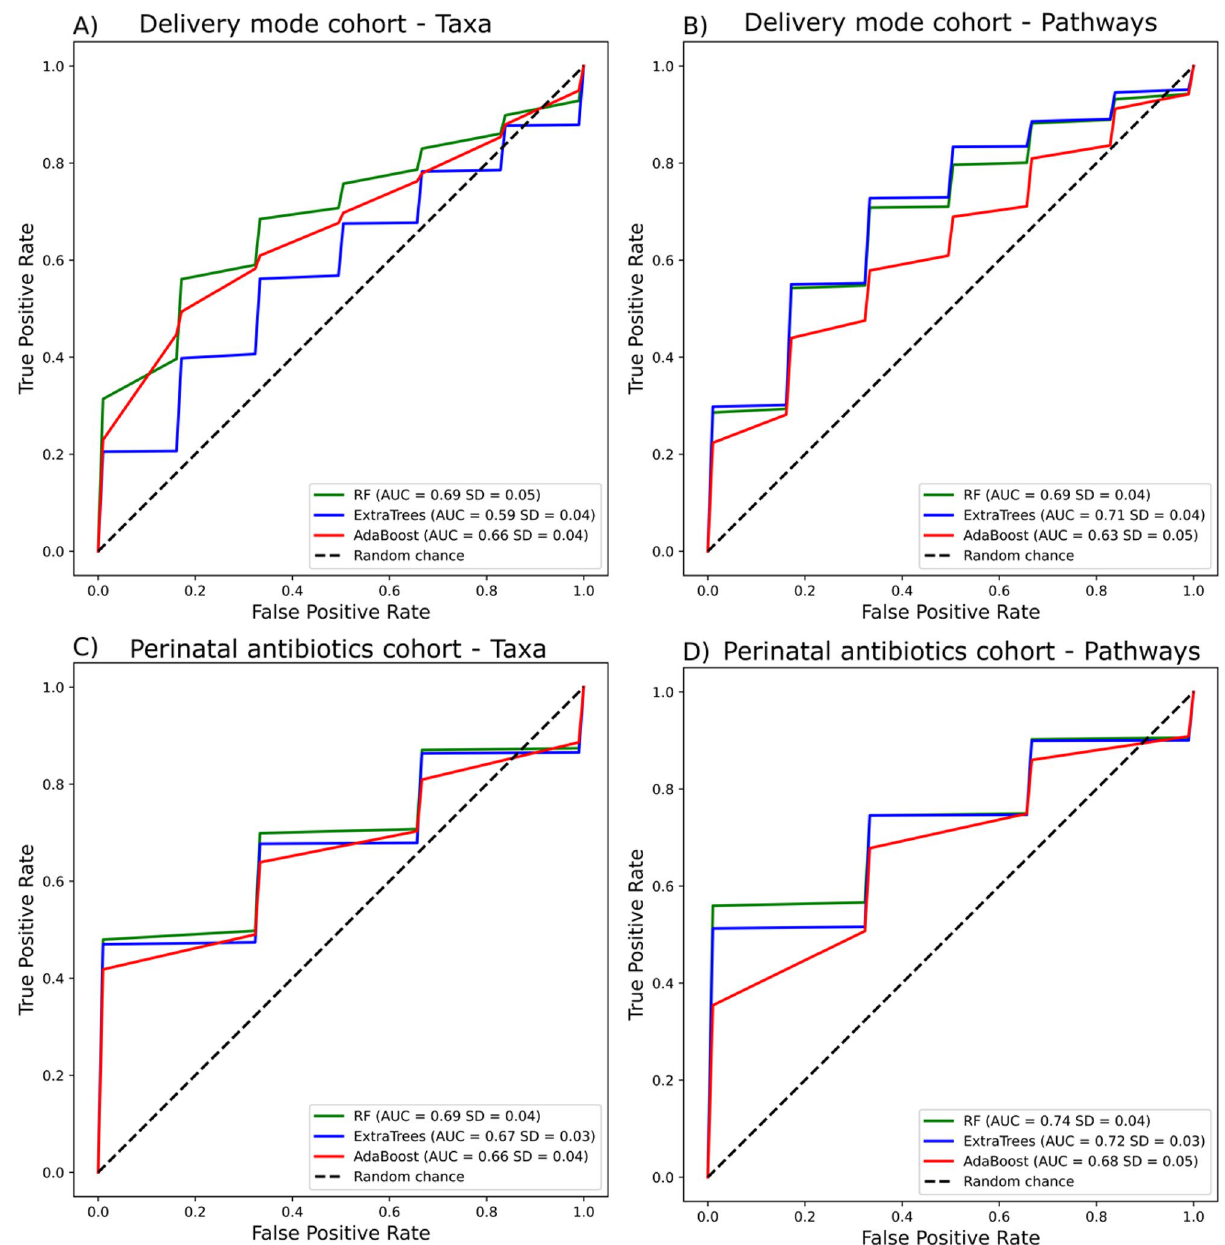
Figure 2. Machine learning model performance when differentiating delivery mode and perinatal antibiotic treatments. Relative abundance data from taxa ( A , C ) and metabolic pathways ( B , D ) were used. Models can have an area-under-the-curve (AUC) value in the range of 0.5 (random chance) to 1.0 (perfect predictor). The black diagonal line represents random chance